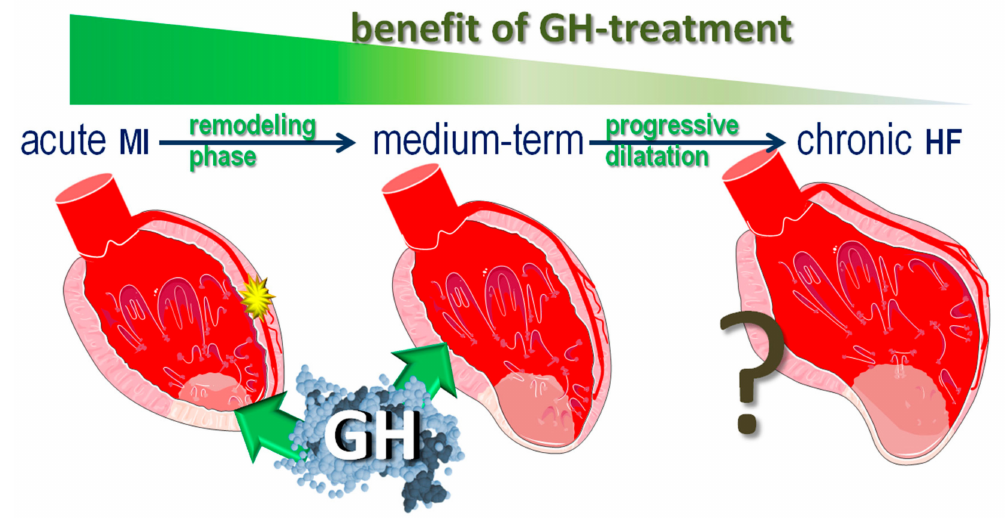
Figure 1. Growth hormone (GH) in myocardial infarction. The actions of GH di ff er along the course of myocardial infarction. It appears that the potential benefit of GH-treatment diminishes over time, pointing toward treatment strategies that aim to prevent adverse